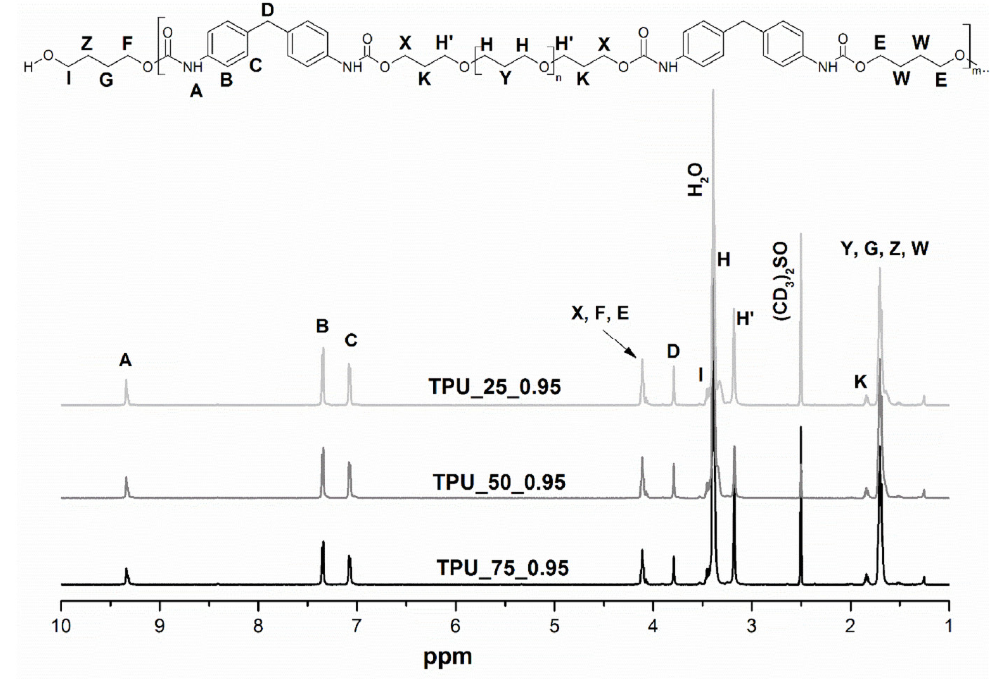
Figure 1. 1 H NMR spectra of prepared green